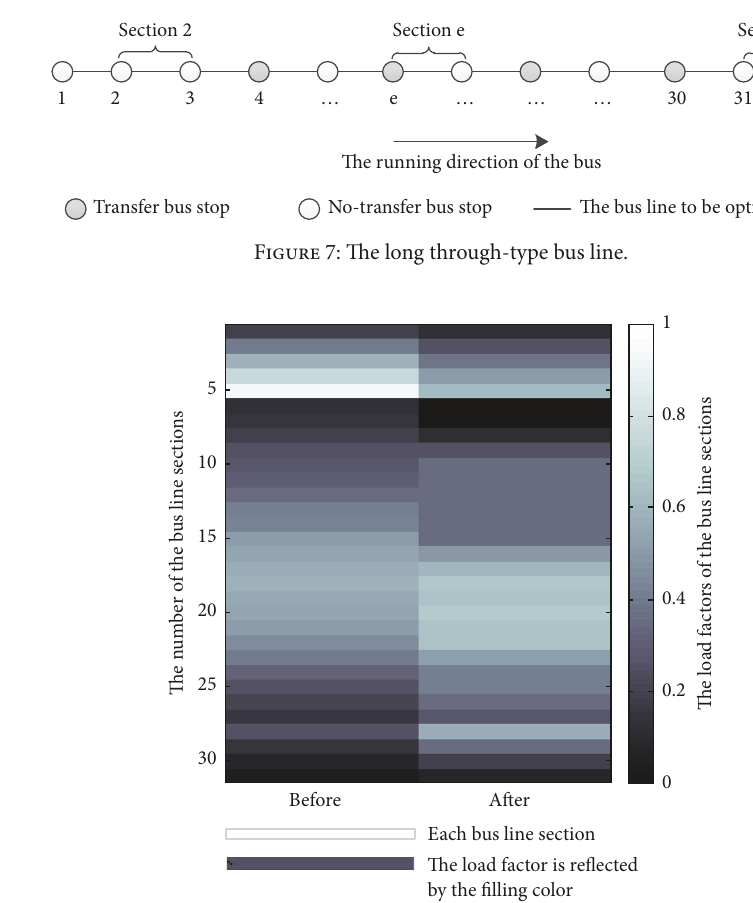
Figure 8: The load factors of the optimized bus line and the original one.